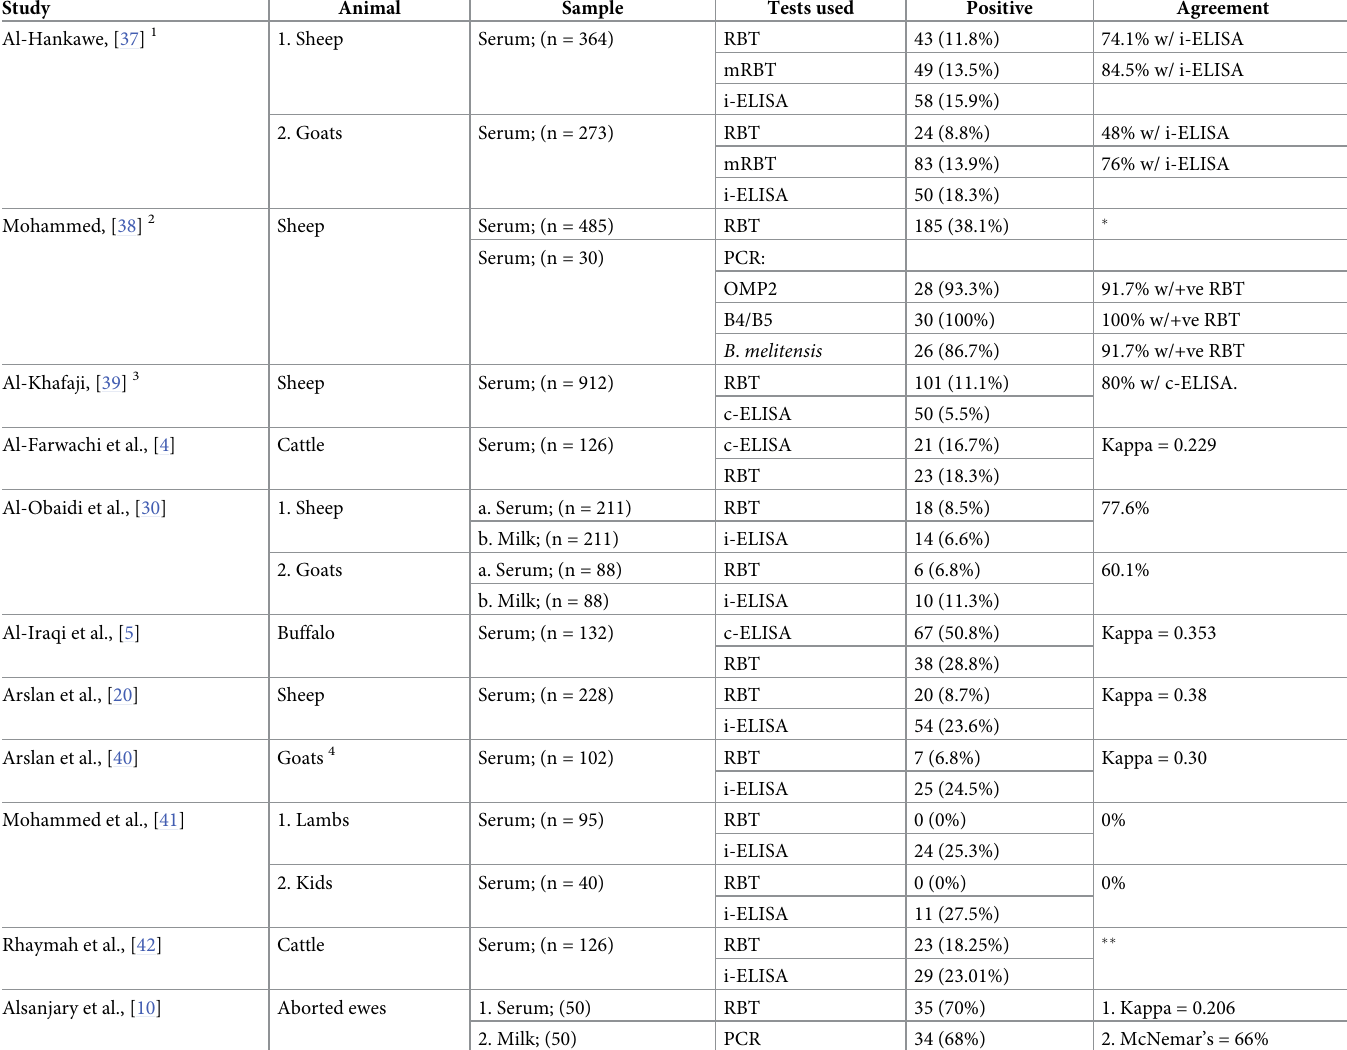
Table 2. Qualified studies that examined brucellosis in different food-producing animals in Mosul, Iraq, with main objective: Assessing different screening tests for the diagnosis.